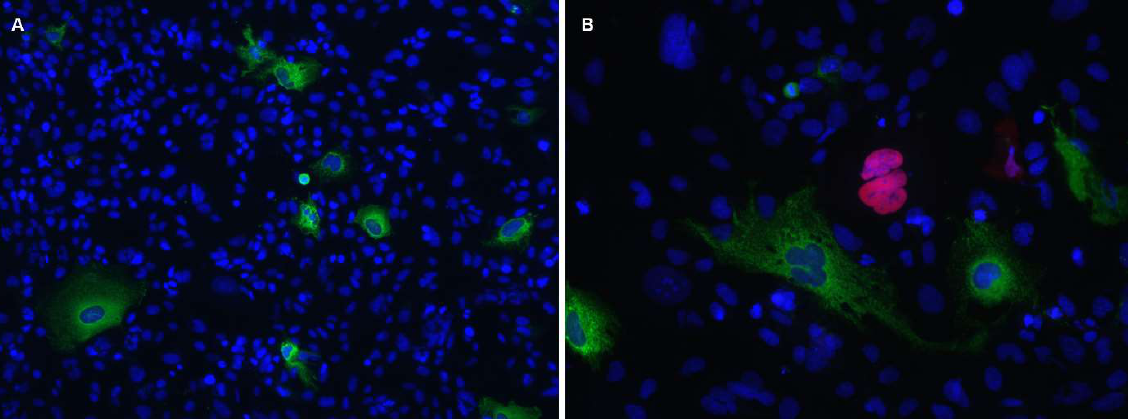
Figure 1. The SVG p12 cell line expresses BKPyV proteins and can be infected by JCPyV. SVG p12 cells were ( A ) mock-infected or ( B ) infected with JCPyV (Mad-4). Cells were fixed 4 d.p.i. and indirect immunofluorescence staining was performed using a BKPyV-specific agnoprotein rabbit polyclonal antiserum in combination with a JCPyV-specific Vp1 mouse monoclonal antibody (ab34756; Abcam). As secondary antibodies goat-anti-rabbit (green, Alexa 488) and goat-anti-mouse (red, Alexa Fluor 568) were used. The DNA (nucleus) was stained with Draq5 (blue). Both images were acquired by Nikon light microscopy with a 10× and 20× objective, respectively.